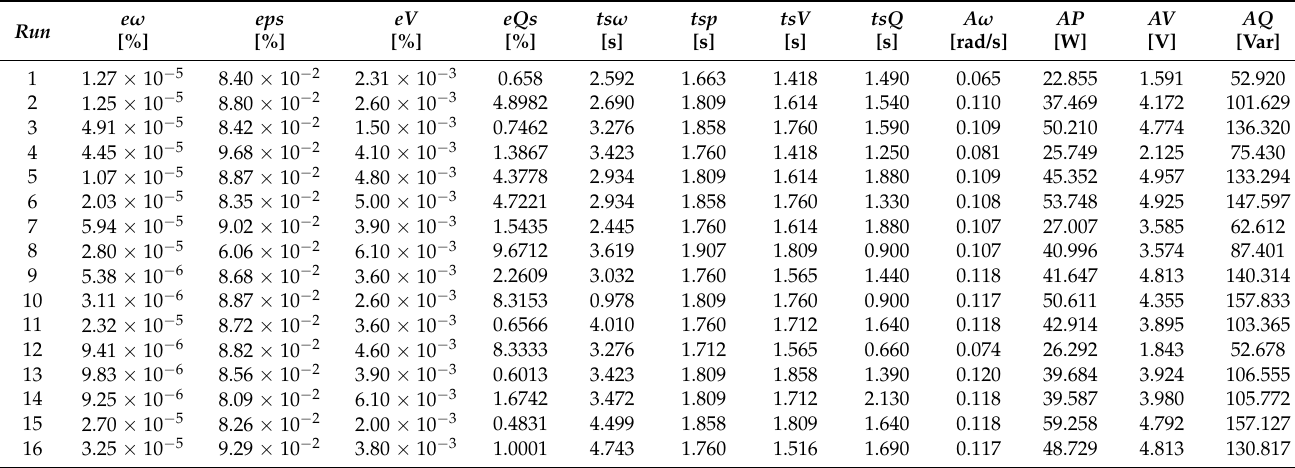
Table 7. Response variables for each experimental run in Table 6